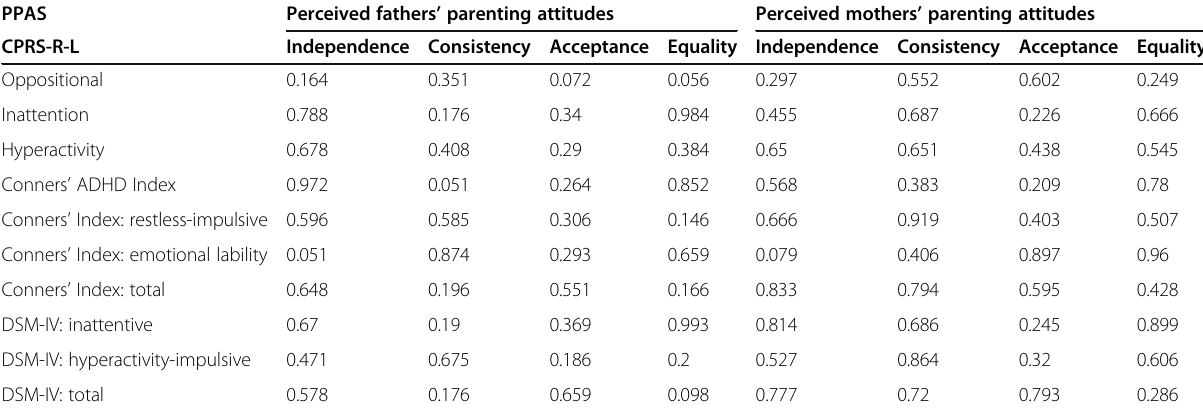
Table 2 P values of correlations between perceived parenting attitudes and severity of ADHD symptoms PPAS Perceived fathers ’ parenting attitudes Perceived mothers ’ parenting attitudes CPRS-R-L Independence Consistency Acceptance Equality Independence Consistency Acceptance